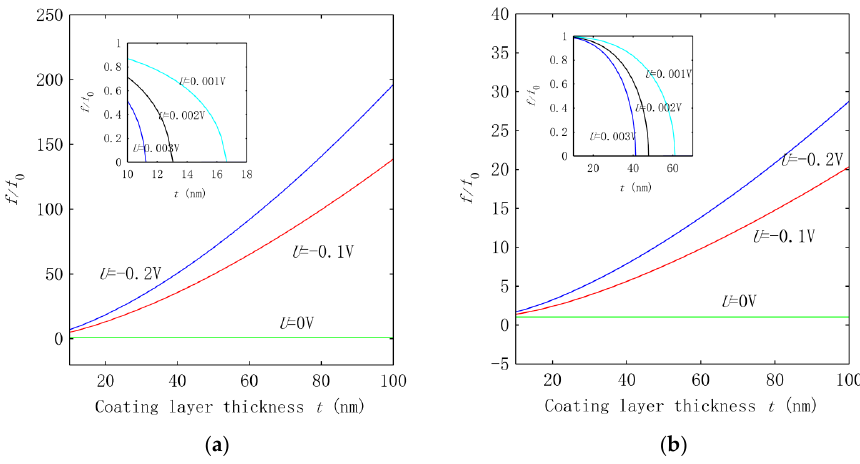
Figure 3. Frequency ratio f / f 0 calculated at U = − 0.2, − 0.1, 0 V. The inset shows the corresponding results associated with U = 0.001, 0.002, 0.003 V.